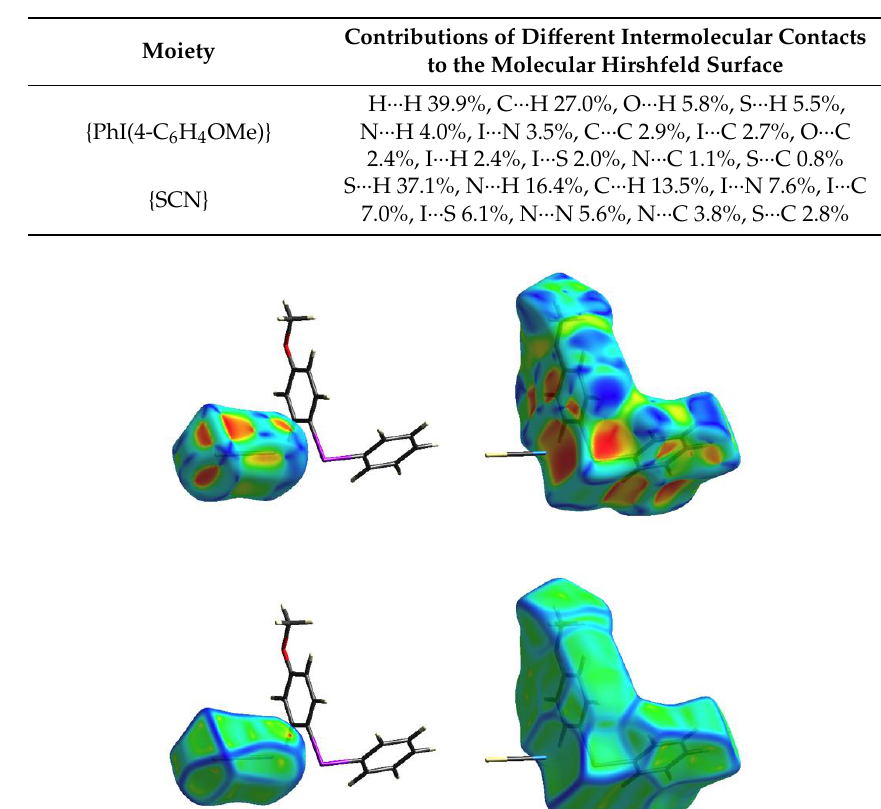
Figure 5. Shape index surfaces (top, color code: hollow—red; bumps—blue) and curvedness index surfaces (bottom, color code: edges—blue; flat regions—green) plotted over the Hirshfeld surfaces of [PhI(4-C 6 H 4 OMe)] + and SCN − ions in the crystal structure of 1 .